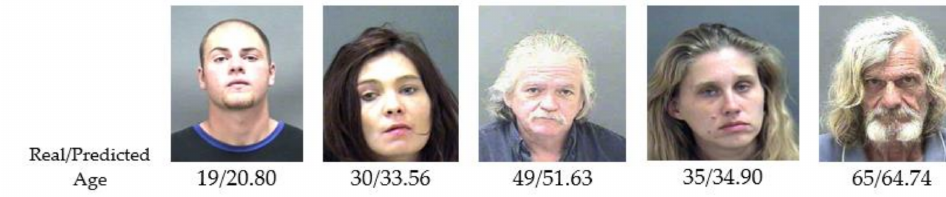
Figure 10. A pictorial presentation of some of the test images with predicted age of the Morph dataset evaluated by our